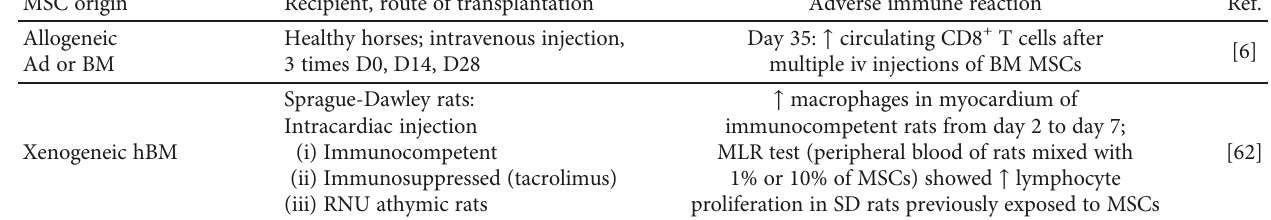
Table 4: Examples of immune reaction after xenogenic or allogeneic MSC transplantation.